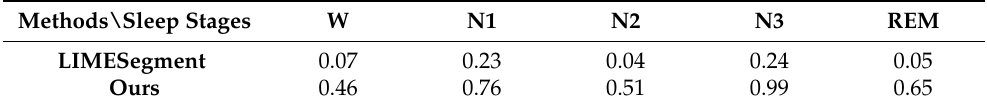
Table 1. The difference of the logit between the input, which is removed from the most representative region and associated original input. The entry describes the mean of the the difference with regard to the sleep stage. Each column is for wakefulness, non-REM 1–3 and REM. Methods\Sleep Stages W N1 N2